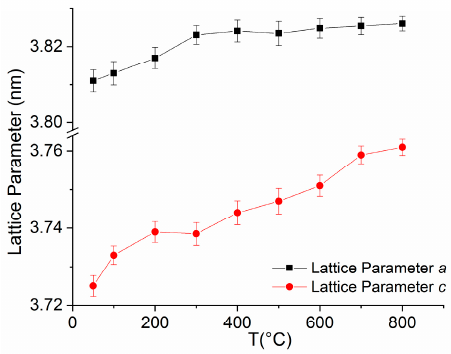
Figure 5. Average grain size of the L1 0 phase as a function of temperature of XRD measurement.